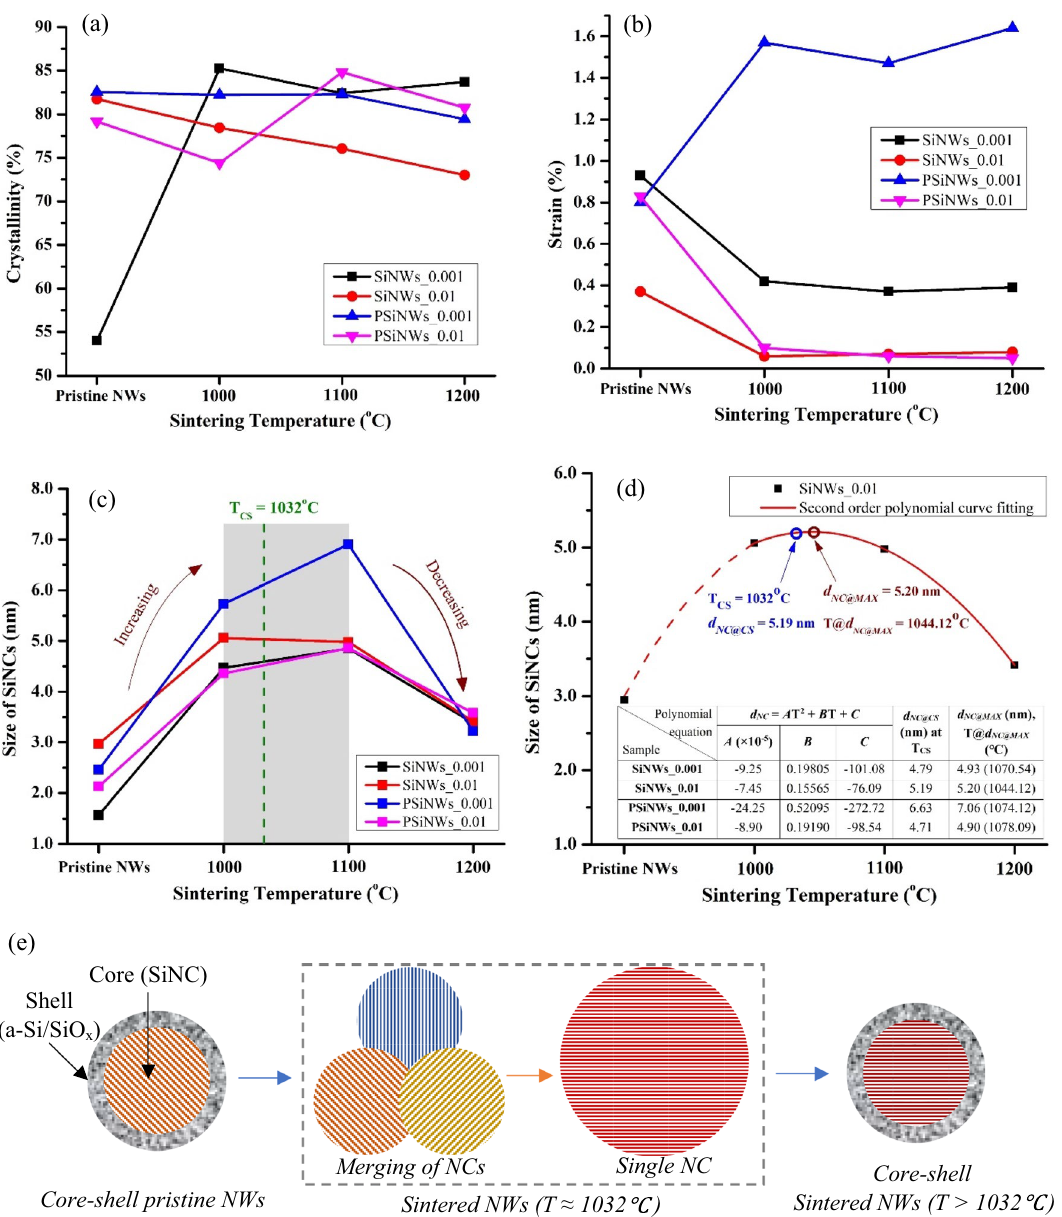
Figure 10. Parameters obtained from Raman characterization for pristine and sintered NWs such as ( a ) crystallinity, ( b ) strain, and ( c ) size of SiNCs (T CS indicates critical sintering temperature). ( d ) second-order polynomial curve fitting for the size of SiNCs ( d NC ) with the sintering temperature (T) for SiNWs_0.01 sample. The table tabulates the fitting parameter values ( A , B , and C ) for all the sintered NWs, d NC@CS at T CS , d NC@MAX , and corresponding sintering temperature T@ d NC@MAX . ( e ) schematic of core–shell pristine NWs structure having smaller NC (T = 1000 °C), merging neighboring SiNCs to form a single larger NC at T ≈ 1032 °C, and formation of core–shell NWs having smaller NCs due to reoxidation at T > 1032 °C.